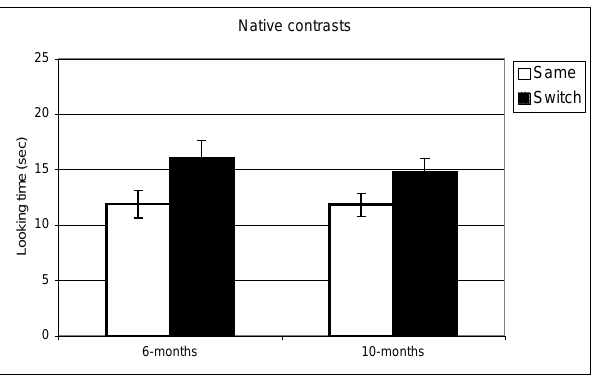
Figure 1. Looking time during same and switch trials for native contrasts at 6- and 10-months.